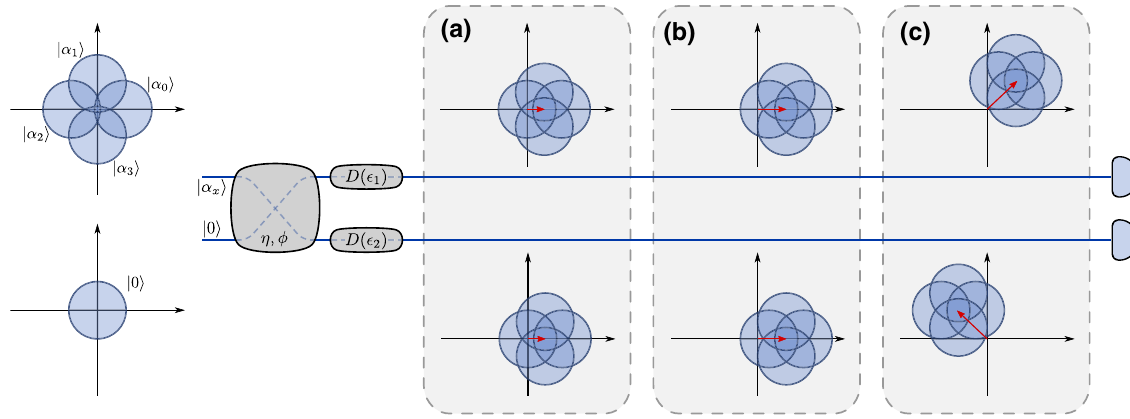
FIG. 7. Illustration of the three receiver schemes implemented in the experiment for discriminating between the four input QPSK states | α 0 (cid:2) , | α 1 (cid:2) , | α 2 (cid:2) , | α 3 (cid:2) . (a) In the nulling Kennedy receiver [44], both BS outputs are displaced such that the | α 2 (cid:2) state is shifted to the phase-space origin. (b) The amplitude-optimized Kennedy receiver [45] is similar to the nulling receiver, but by displacing | α 2 (cid:2) further past the origin, the success probabilities for weak amplitudes are significantly improved. (c) Our optimal receiver also optimizes the phases of the displacements on the two BS outputs, leading to further